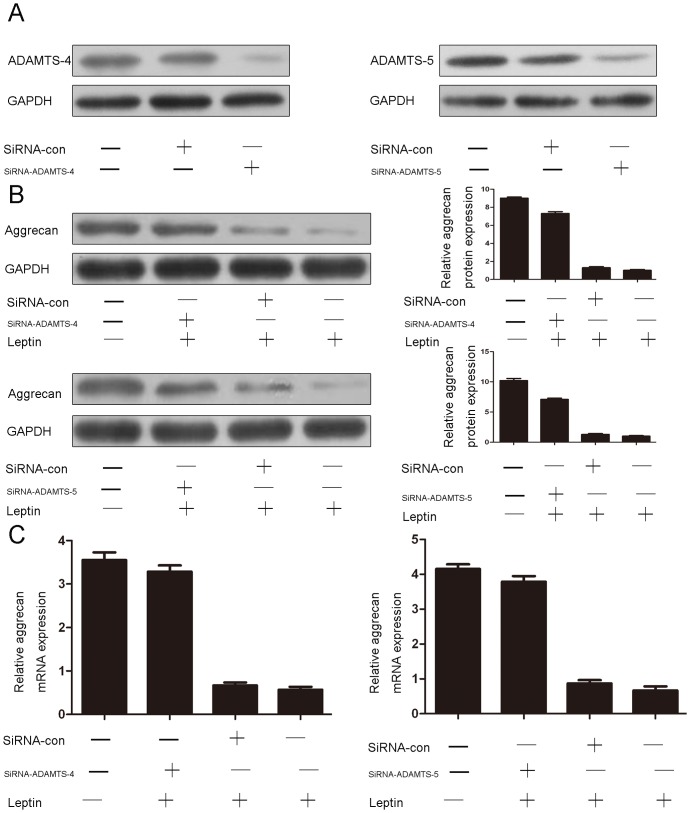
ADAMTS-4 and ADAMTS-5 silencing attenuated leptin-induced aggrecan degradation in NP cells.(A) The protein expression of ADAMTS-4 and -5 were detected with western blotting analysis using GAPDH as an internal control. (B) NP cells were treated with control SiRNA (SiRNA-con), 10 ng/ml leptin, SiRNA-ADAMTS-4 or SiRNA-ADAMTS-5 for 48 h. The amouts of aggrecan protein were detected with western blotting analysis using GAPDH as an internal control. The signal in each lane was quantified using ImageJ software and the ratio of aggrecan to GAPDH was determined. (C) Aggrecan mRNA expression were detected with Real-time RT-PCR analysis using GAPDH as an internal control. Error bars represent standard deviration.